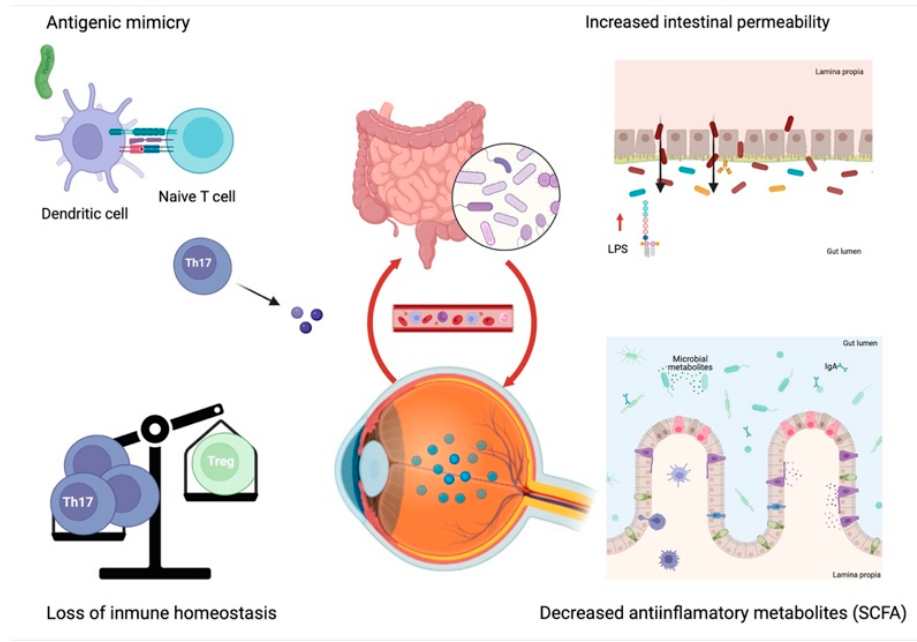
Figure 1. Mechanisms by which dysbiosis can participate in the pathogenesis of uveitis. Created with BioRender.com.